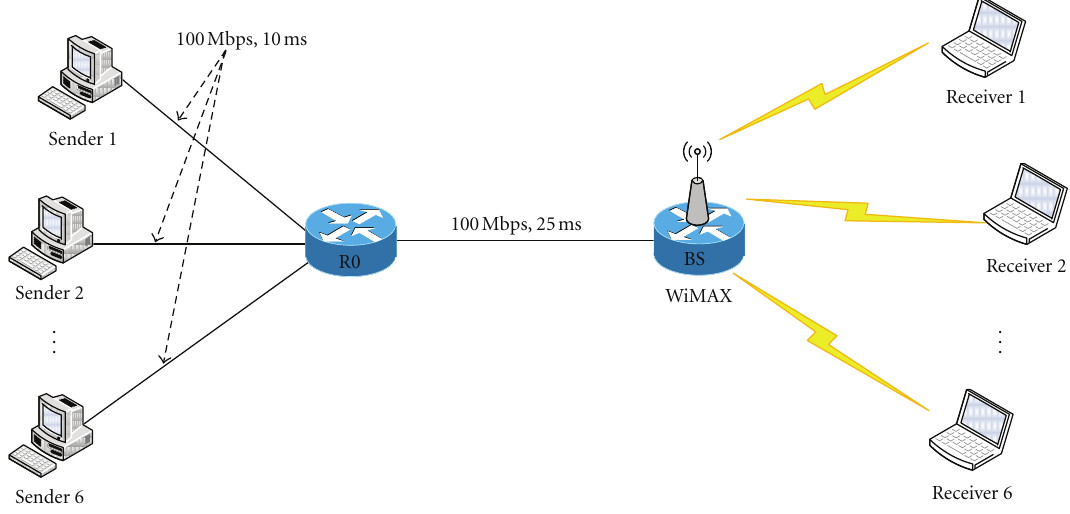
Figure 9: Multiple TCP flows in a WiMAX